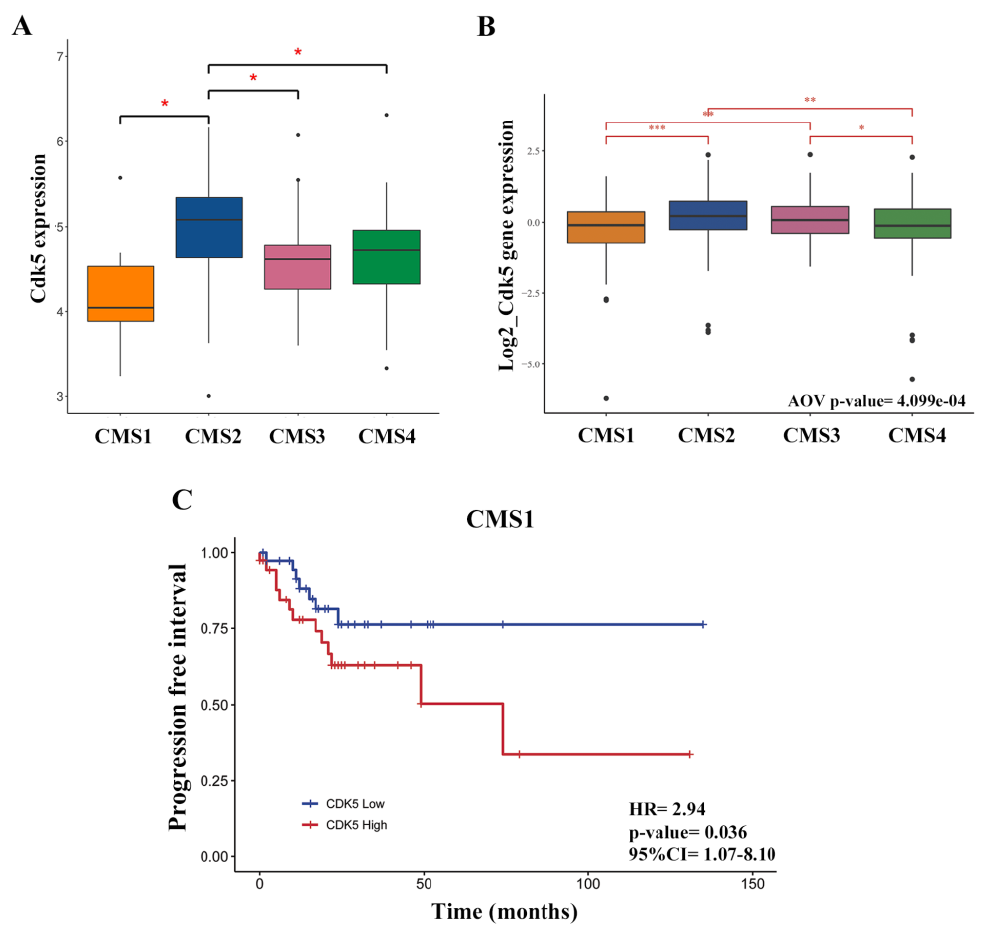
Figure 6. Cyclin dependent kinase 5 (Cdk5) expression in the four consensus molecular subtypes (CMS). ( A ) Dunn and Kruskal–Wallis multiple comparison of Cdk5 expression in CMS in 98 stage II tumors. Note that only six cases were classified as CMS1 as this cohort was restricted to microsatellite stabile (MSS) cases ( B ) ANOVA analysis of Cdk5 expression levels in the CMS in the cancer genome atlas - colorectal adenocarsinoma - rectal adenocarcinoma dataset (TCGA-COAD-READ) including 410 stage I–IV patients. * p -value < 0.05, ** p -value < 0.01, *** p -value < 0.001. ( C ) PFI in the